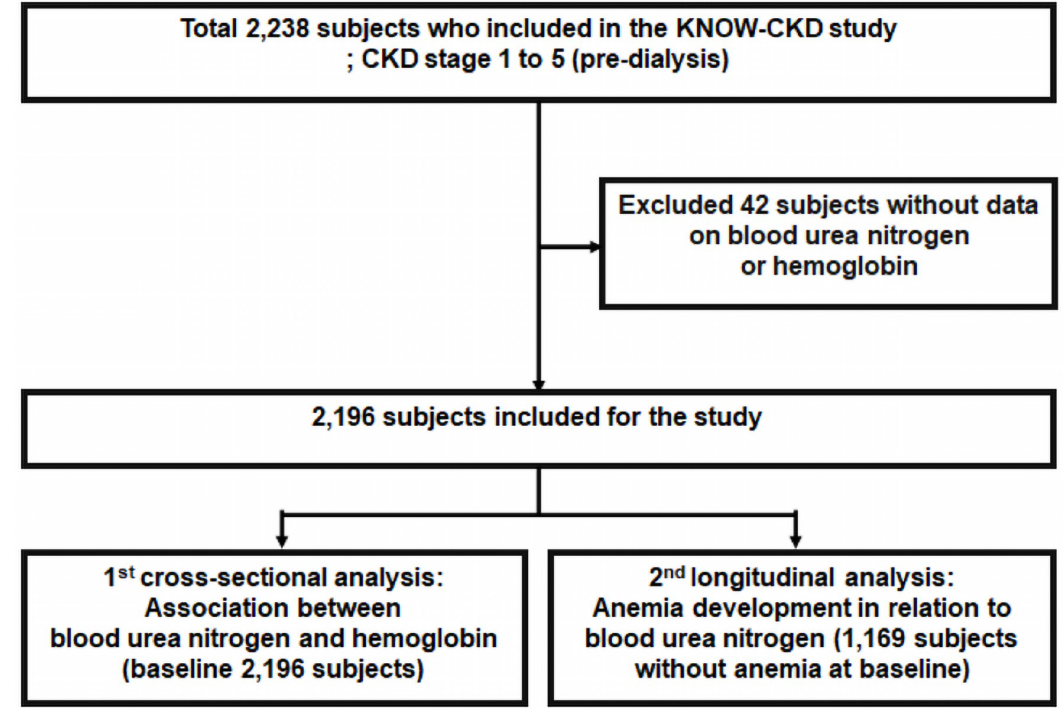
Fig 1. Flow chart of subject enrollment and